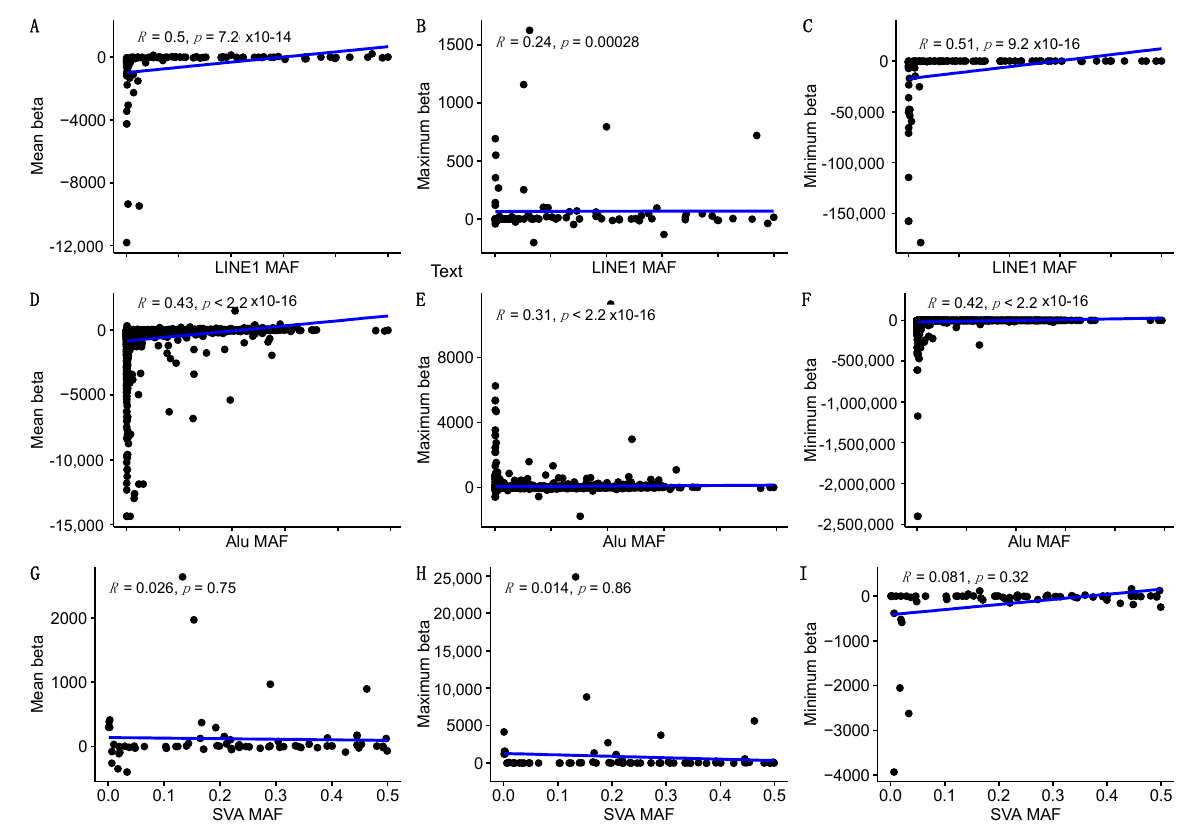
Figure 3. Correlation analysis between allele frequencies and beta values for L1, Alu and SVA. A , B and C show correlation between LINE1 MAF and its effect size and direction. D , E and F show correlation between Alu MAF and its effect size and direction. Panels G , H and I show correlation between SVA MAF and its effect size and direction. Mean beta is an average effect size for a specific TE, maximum beta shows activating effects for specific TE and minimum beta indicates suppressive regulatory effect. The effect of LINE1 and Alu elements had clear MAF dependent correlation. SVA effect did not correlate with MAF.